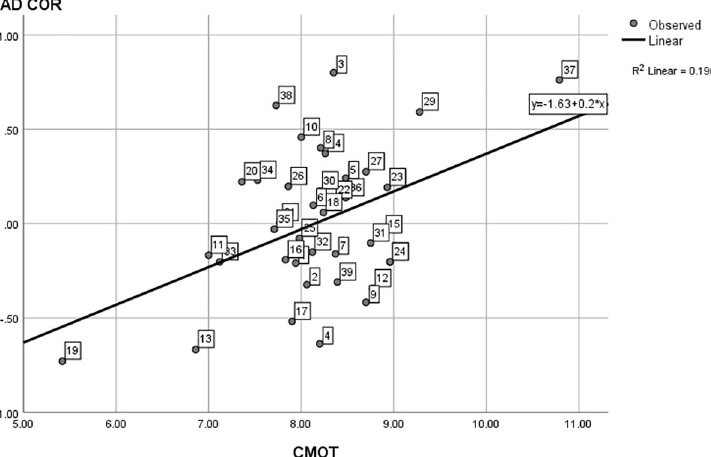
Fig 4. The linear regression of interest diversity on controlled motivation. Interest Diversity is measured using AD COR (based on D COR z–scores), with CMOT = controlled motivation. The data points (dotted study programs) are labeled analogous to Table